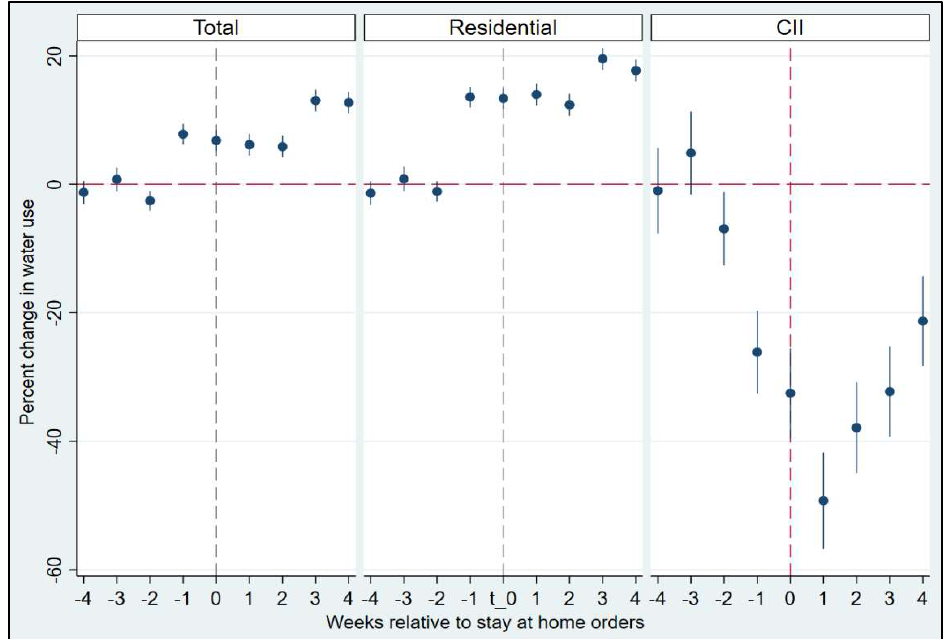
Figure 3. Weekly percent change in water use before and after the stay-at-home orders in Utility E (Montana) for total, residential, and CII sectors.